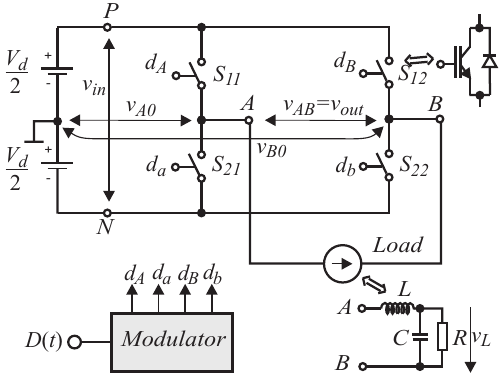
Figure 1. Single-phase inverter structure; the semiconductor switch structure; the (current source) load